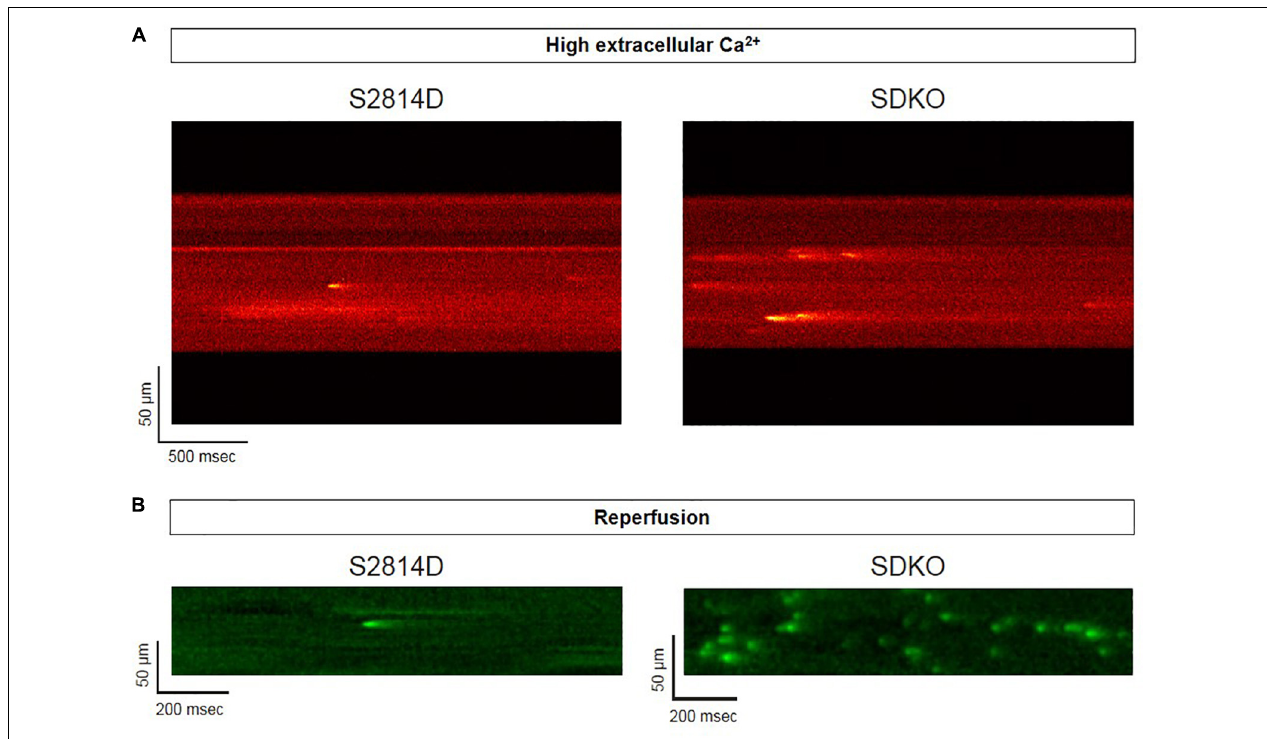
FIGURE 5 | Confocal assessment of spontaneous Ca 2 + release. (A) Representative confocal images showing that Ca 2 + spark frequency is higher in isolated cardiomyocytes from SDKO mice in comparison to S2814D myocytes (unpublished confocal microscopy records representative of overall data shown in Mazzocchi et al., 2016). (B) Similar results were obtained in fluo-4 loaded intact isolated hearts from S2814D and SDKO mice under a confocal microscope, during reperfusion of the hearts submitted to a period of ischemia (unpublished confocal microscopy records representative of overall data shown in Valverde et al., 2019). In both examples, ablation of PLN increases Ca 2 + spark frequency respect to hearts from S2814D